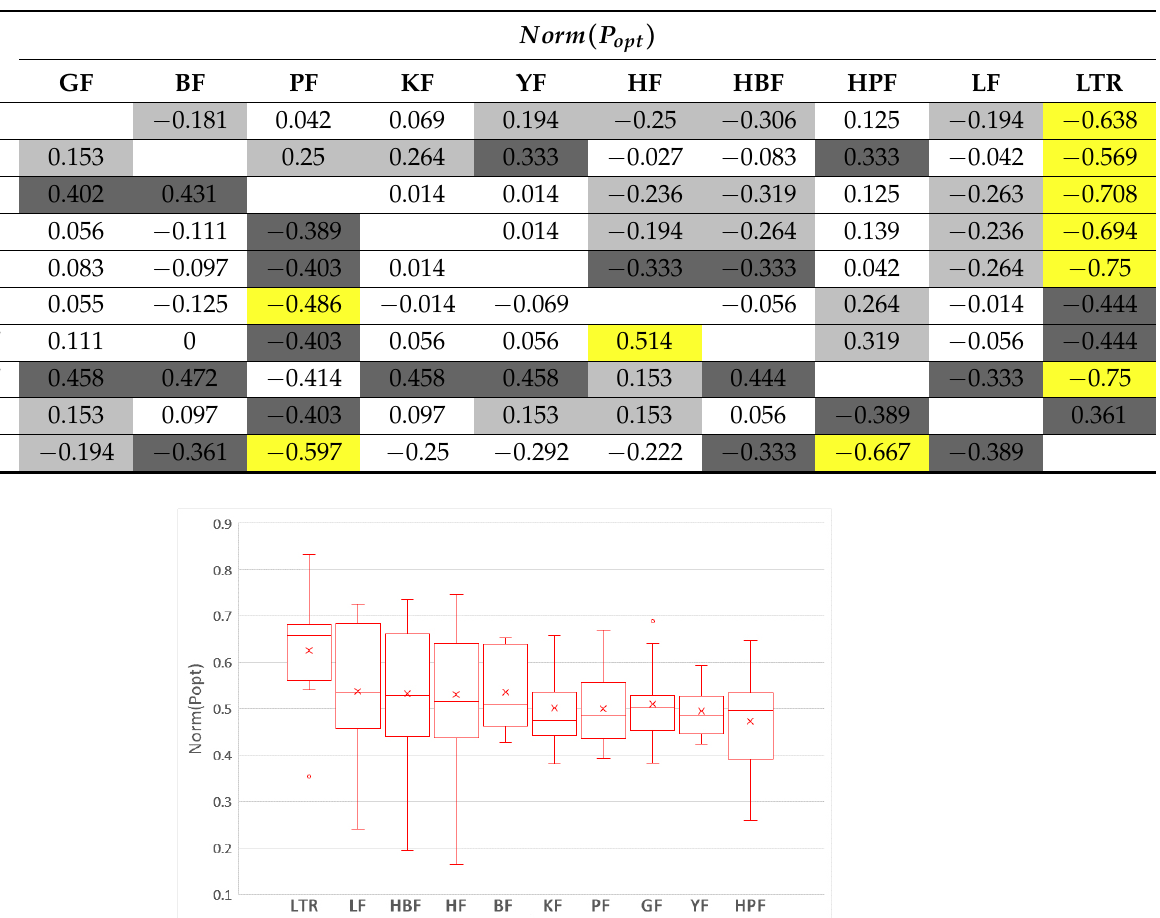
Table 4. Cliff’s δ of the Nine Training Data Selection Methods and LTR Trained on 90% WP Data in Terms of FPA and Norm ( P opt ) .